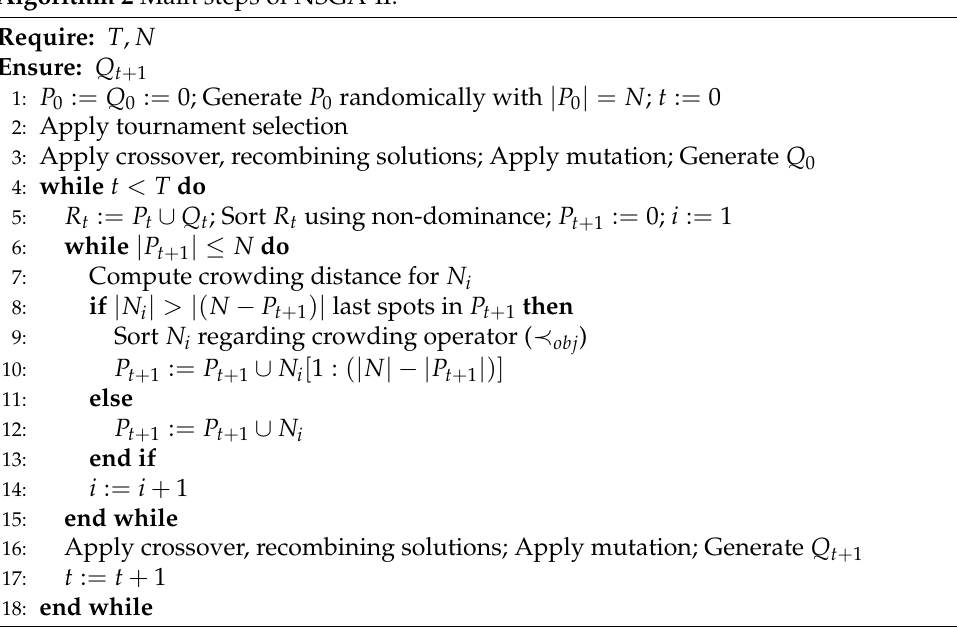
Algorithm 2 Main steps of